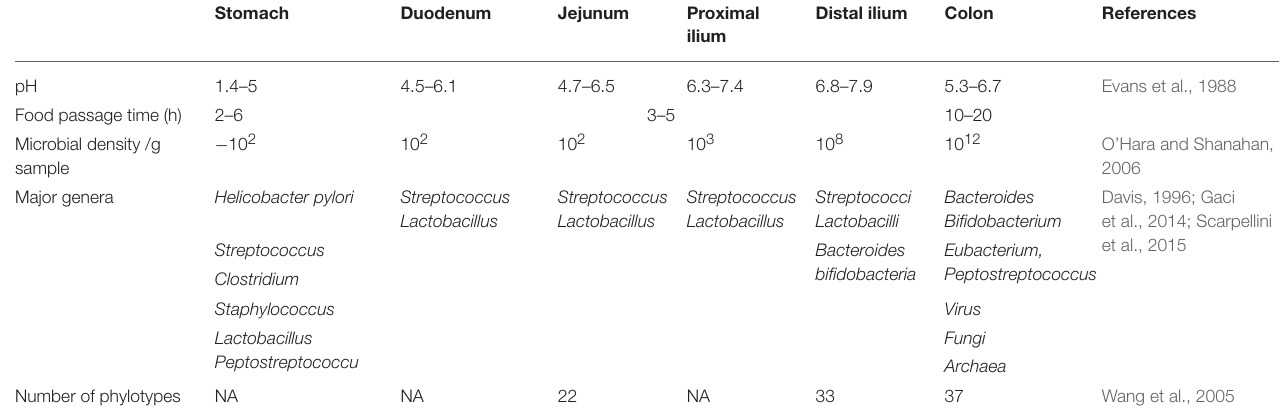
TABLE 6 | Diversity of microbes along the human